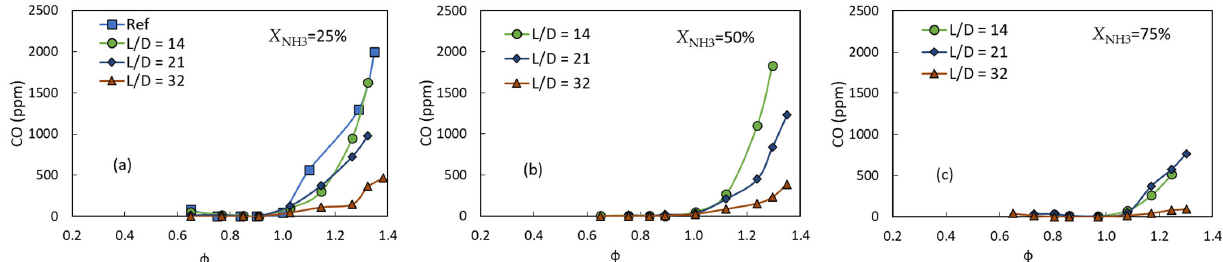
Figure 5. Measured CO concentrations at different equivalence ratios for different mixing length ratios at a fixed ammonia fraction, e.g., ( a ) 25, ( b ) 50 and ( c ) 75%. The reference case in ( a ) is for a neat methane-air mixture at L / D = 32.